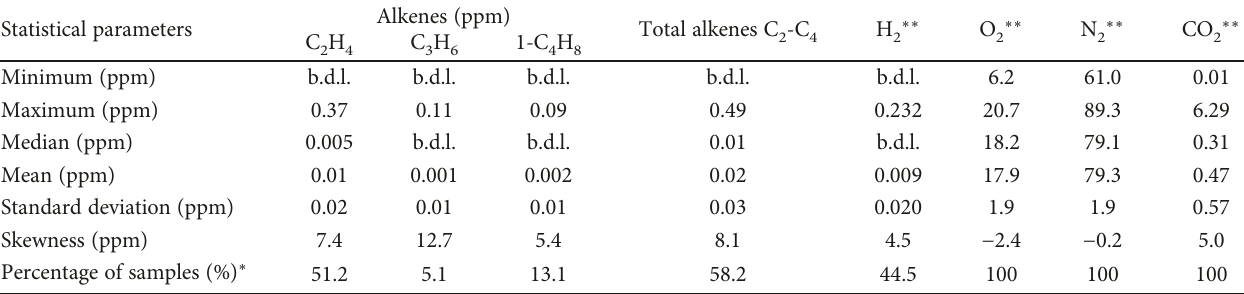
Table 5: Principal statistical parameters of alkene and nonhydrocarbon gas concentrations in analyzed soil gas samples. Statistical parameters